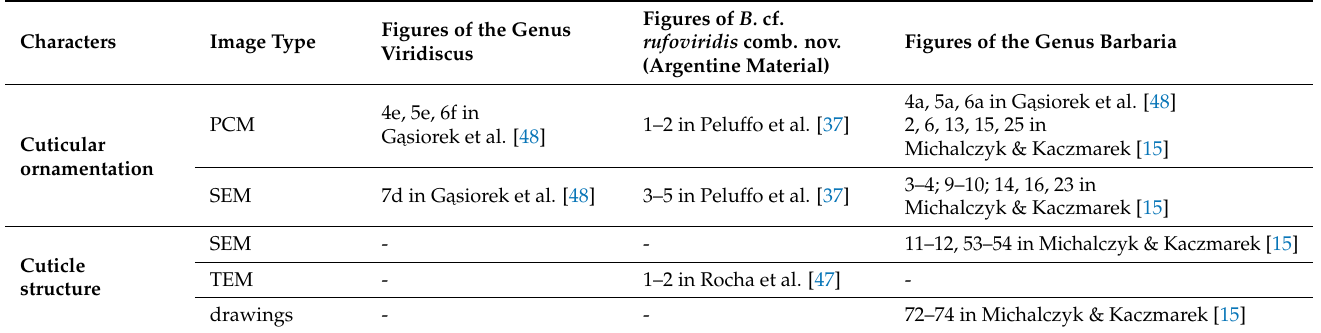
Table 3. References for the various images from [15,37,47,48] showing the cuticle characteristics of the genera Viridiscus and Barbaria , and of B. cf. rufoviridis comb.